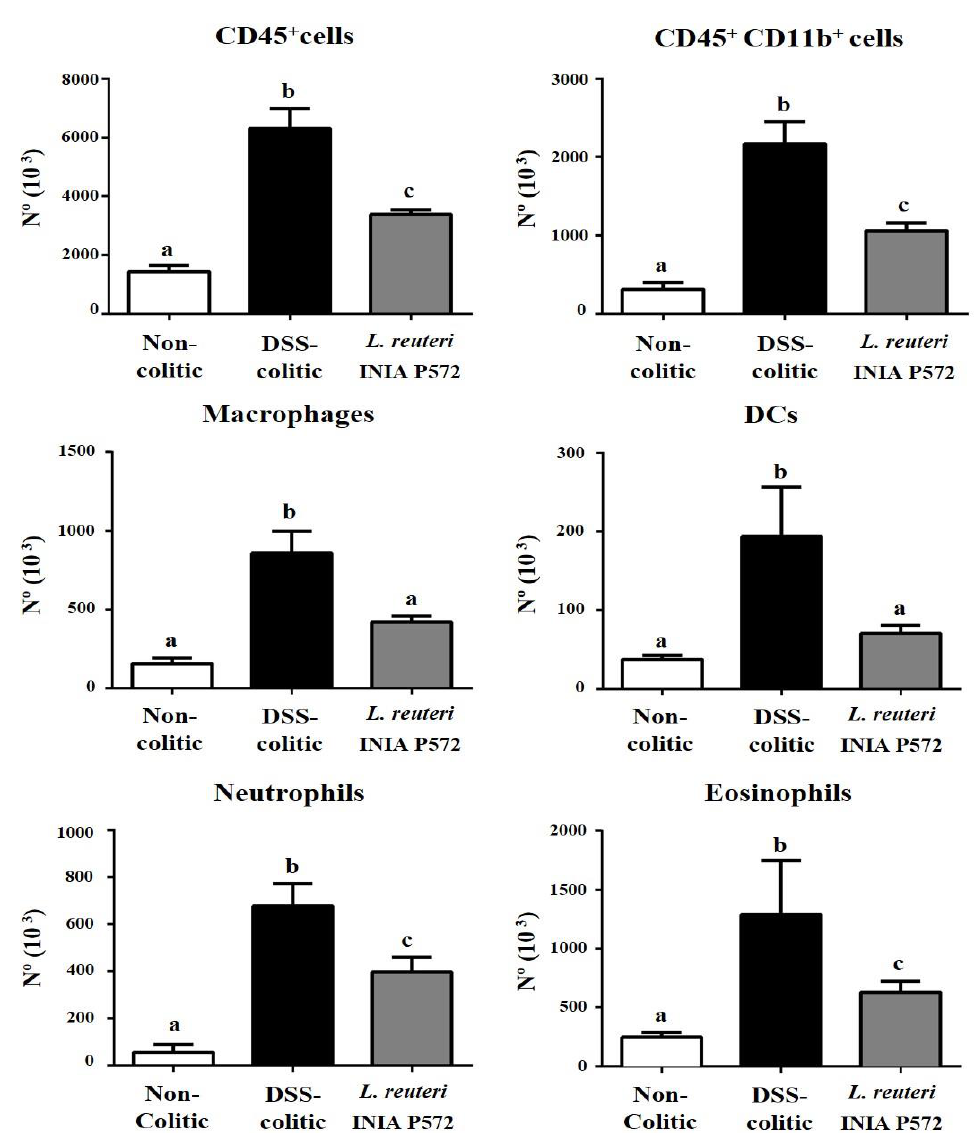
Figure 6. Evaluation of the effect of L. reuteri INIA P572 on the immune response in DSS-colitic mice. Analysis of the indicated immune cell population in the colonic lamina propria of the different experimental groups. Absolute cell numbers of immune cells (CD45+), lymphoid cells (CD11b+), macrophages (F4/80+), dendritic cells (CD11c+ MHCII+), neutrophils (LY6G+), and eosinophils (SiglecF+). Data are expressed as mean ± SEM ( n = 10). a,b,c Groups with different letters statistically differ ( p < 0.05).